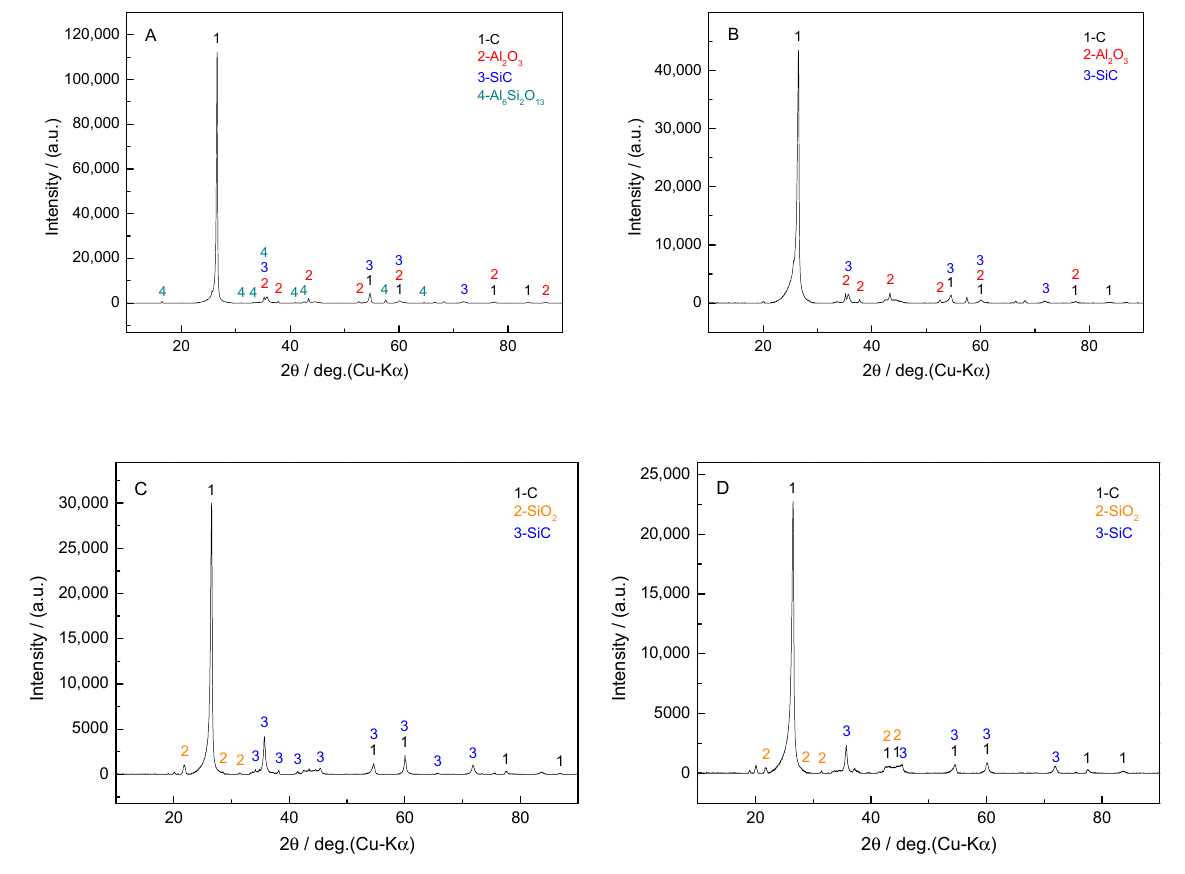
Figure 3. XRD patterns of the four types of carbon bricks ( A – D are the types of carbon bricks). Table 3. Physical and chemical properties of the four types of carbon bricks.